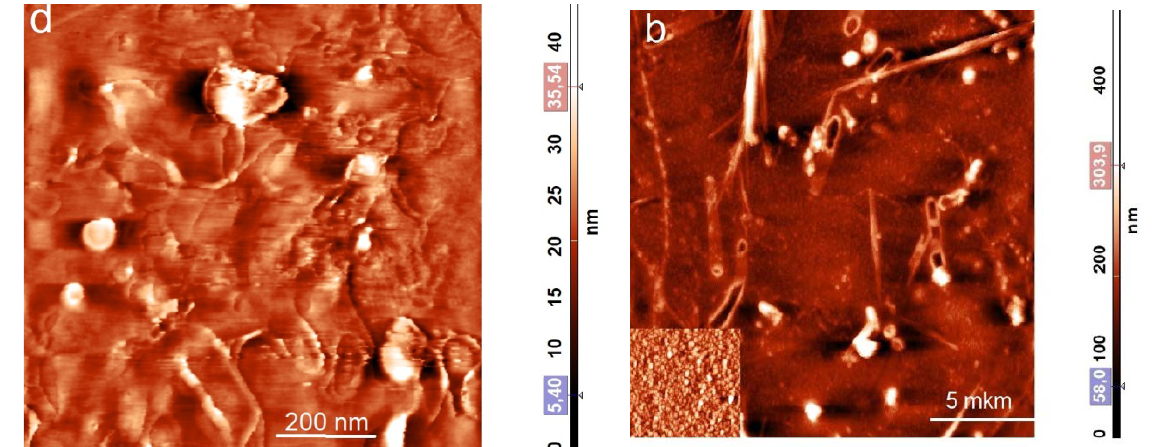
Fig. 1 . AFM images of thin layers of DPT-0 on the surfaces of graphite (a) and gold (b). consist of strands with different widths. At low